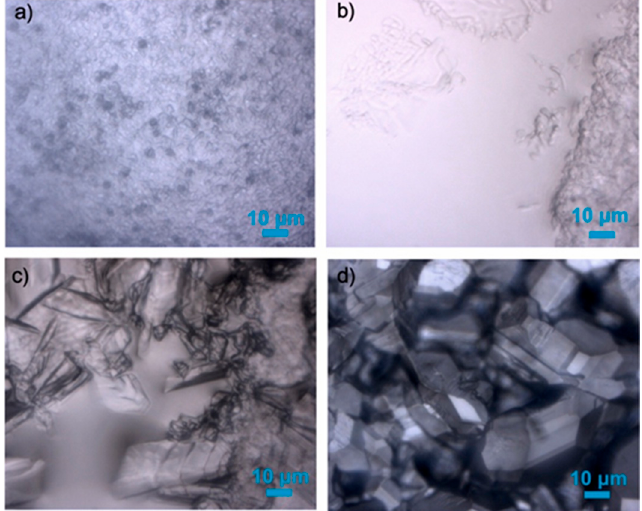
Figure 8. Steps of mixed gas hydrate synthesis from liquid water. ( a ) Formation of ice and mixed gas hydrates, ( b ) melting of ice with only a few hydrate structures left, ( c ) formation of mixed gas hydrates at a temperature above ice point, and ( d ) euhedral hydrate crystals.